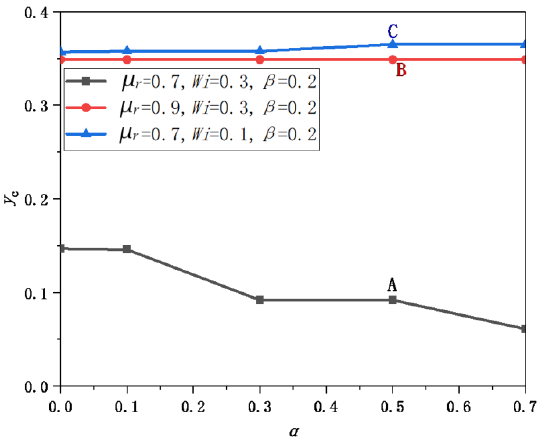
Figure 6. y c as a function of α for different values of µ r and Wi ( β = 0.2).